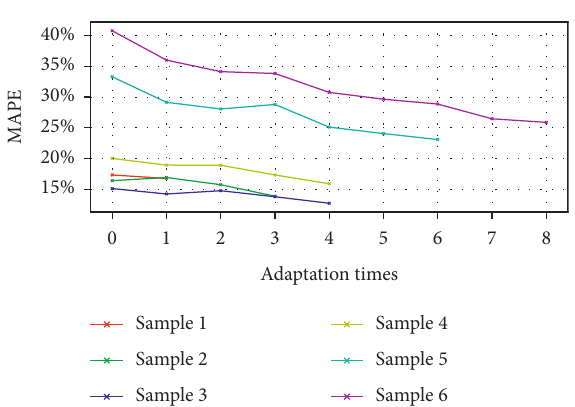
Figure 18: MAPE of full-recovery time along with the increase in adaptation